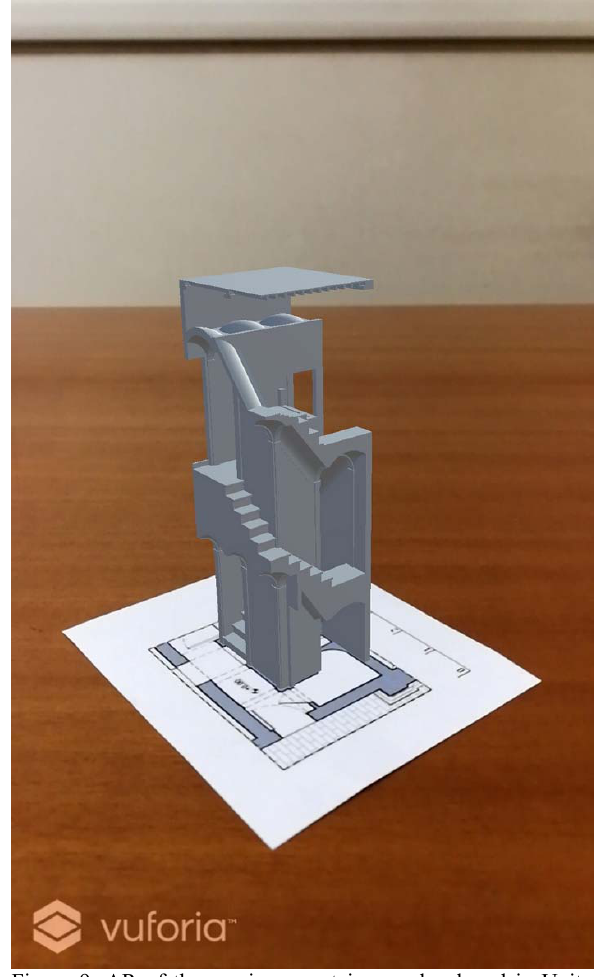
Figure 9: AR of the renaissance staircase, developed in Unity with Vuforia